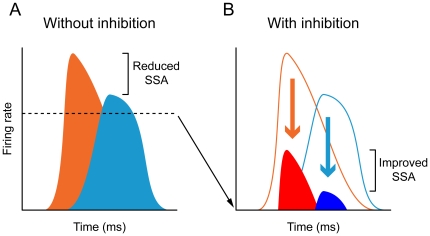
Model of SSA modulation by inhibition.(A) In the absence of inhibition, neurons respond to deviants (orange) and standards (light blue) with high firing rates, and thus the deviant to standard ratio is small. (B) Inhibition reduces the responses to both deviants (red) and standards (dark blue) increasing the deviant to standard ratio and thus enhancing SSA.